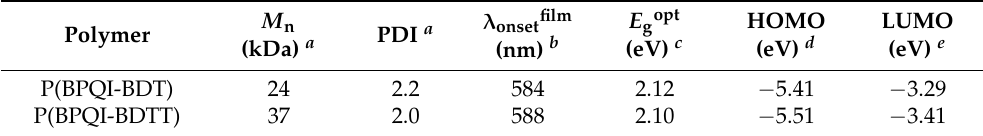
Table 1. Molecular Weights and Optical and Electrochemical Properties of Polymers.